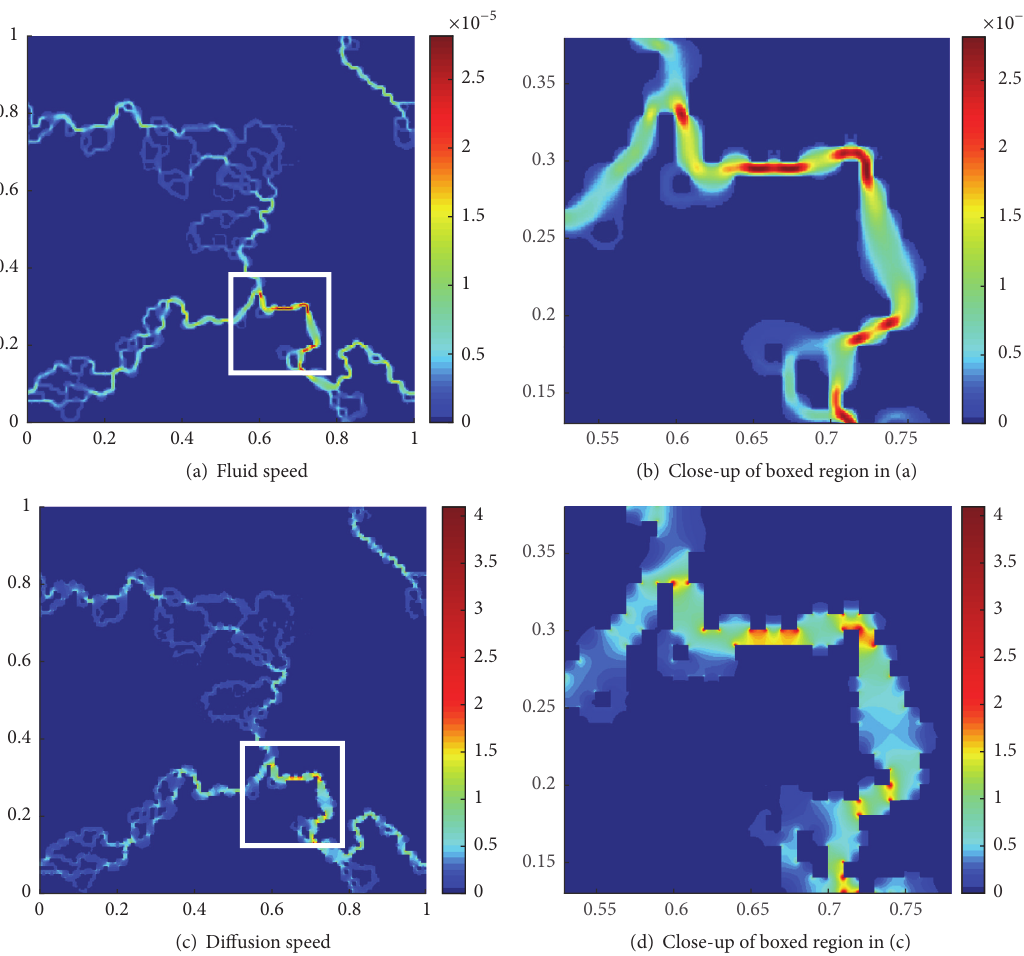
Figure 25: Comparison of hydraulic and diffusive flows through a low porosity geometry comprised of randomly distributed squares: 𝜙 = ∇𝐶 = 1 from west to east. “Hot spots” of fastest moving hydraulic flow are 0.45 . (a, b) Fluid flow driven by 𝑔 𝑥 . (c, d) Diffusive flow driven by evident in channel centers, while diffusive speeds are fastest along fluid-solid